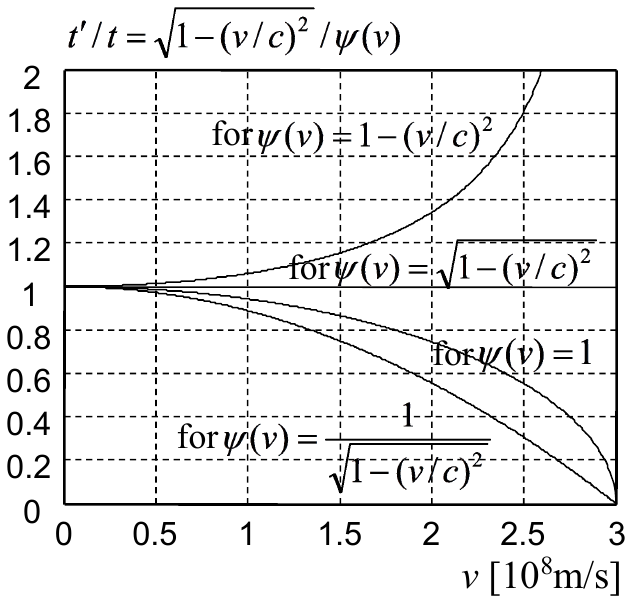
Figure 6. Time dilation for four kinematics of the Special Theory of Ether. The graphs show the ratio of time t (cid:48) measured in the inertial system to time t measured in the universal frame of reference. Body size measured at any angle to the direction of velocity v is indicated by D (0) = D (cid:48) and D ( v ), i.e., without indexes x and y . If the angle α (cid:48) is measured in the body (cid:48) s rest